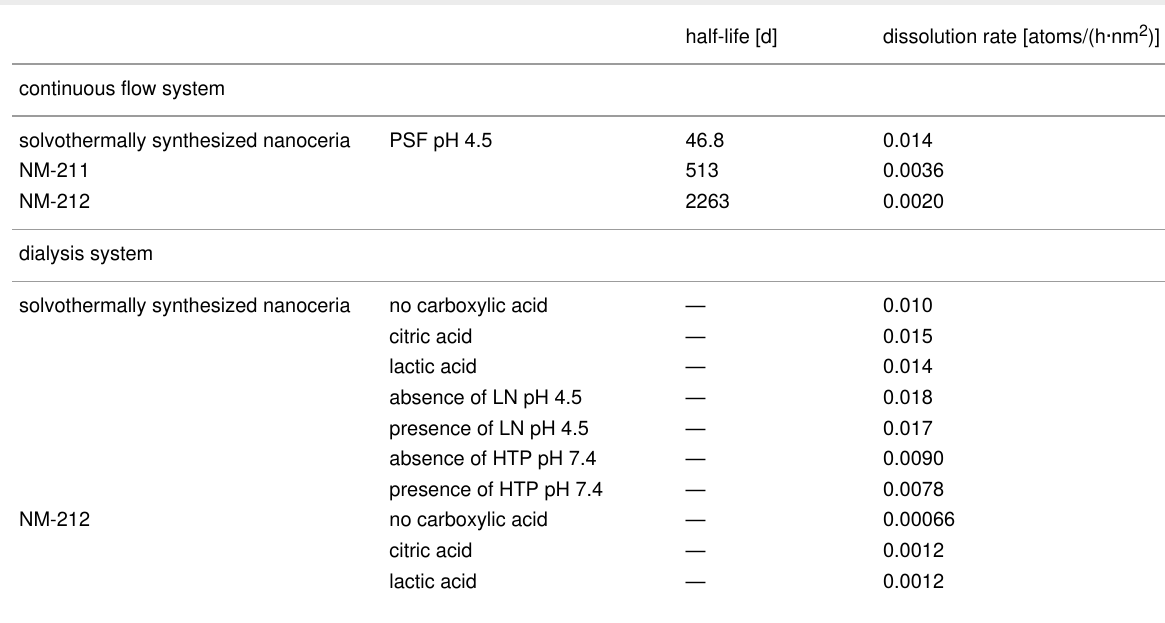
Table 2: Half-lives and dissolution rates of the tested nanoceria. continuous flow system solvothermally synthesized nanoceria